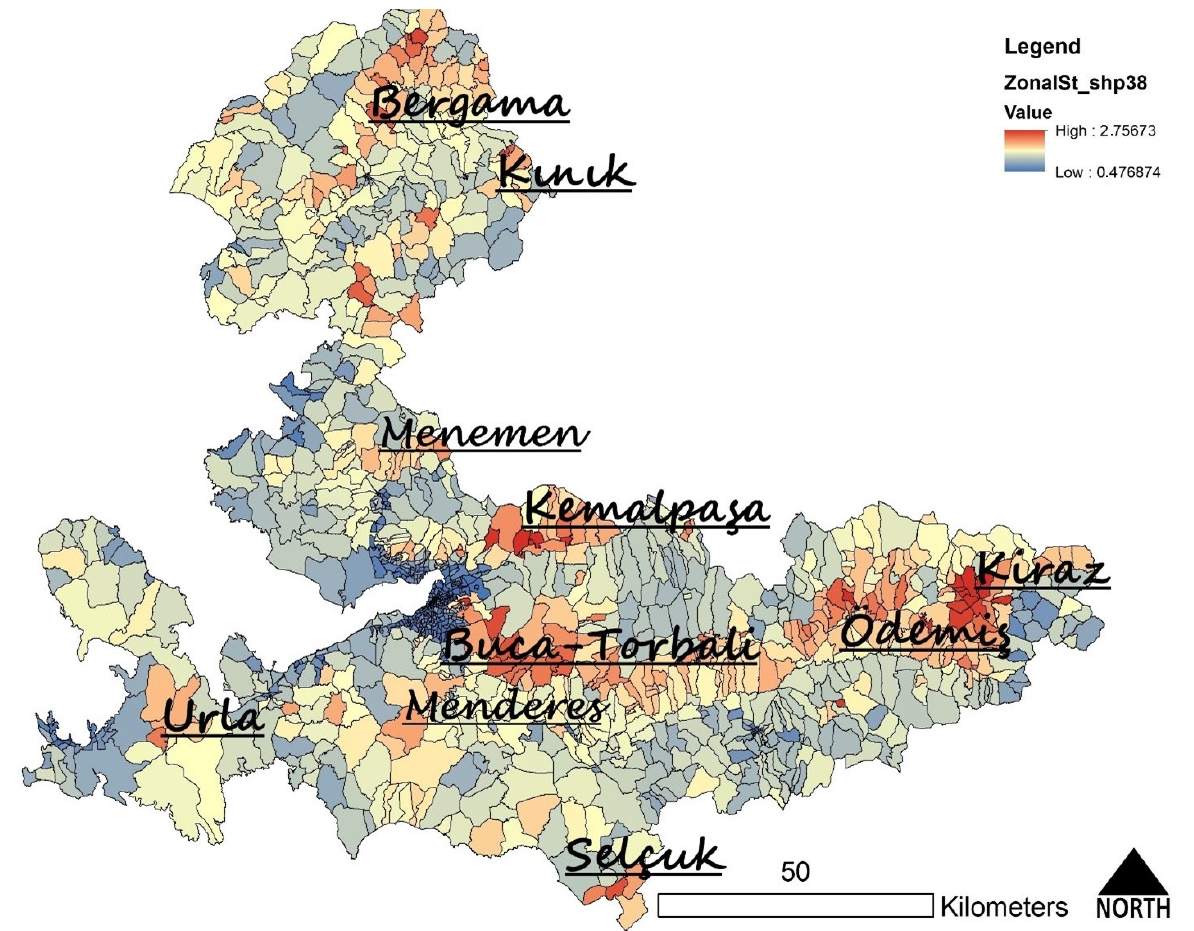
Figure 5. Spatial distribution of the potential vineyard production districts. Source: author’s elabo- ration.